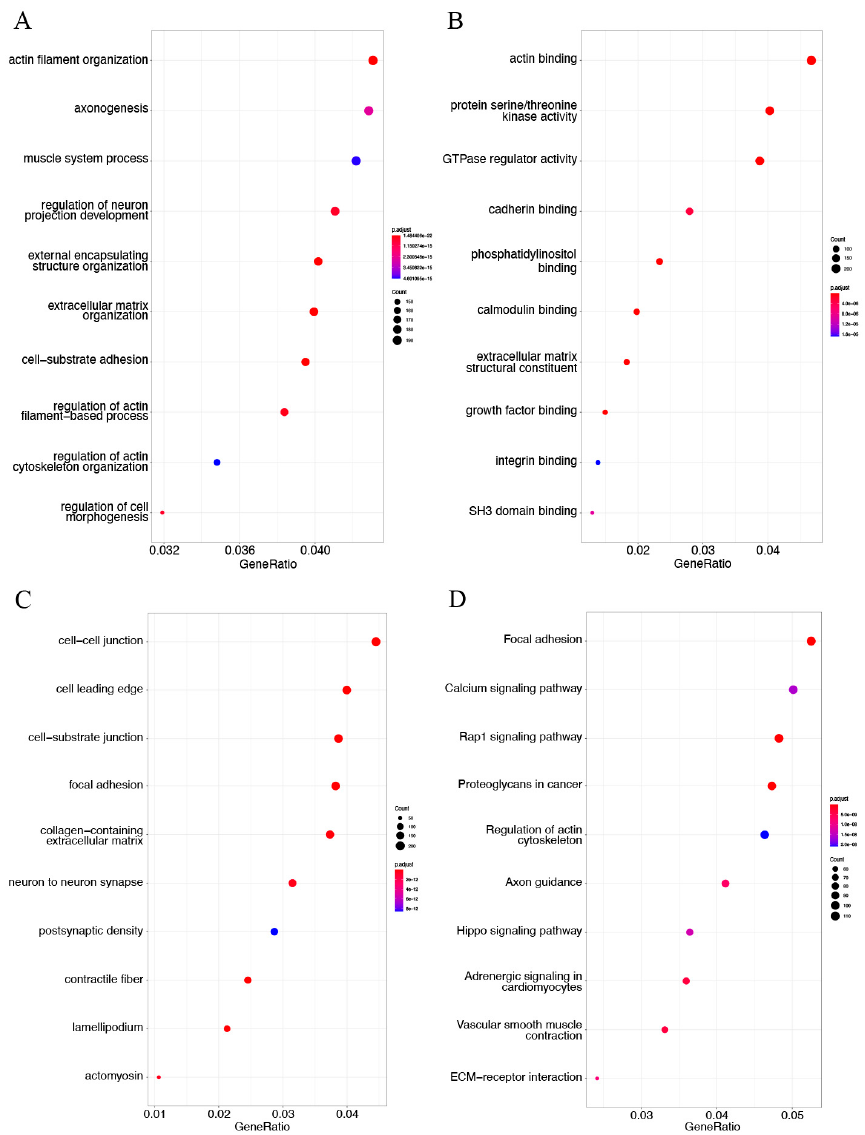
Figure 7. GO term annotation and KEGG pathway analysis of hypermethylated DMGs in AS in GSE46401. Detailed information relating to changes in the ( A ) biological processes (BP), ( B ) molecular functions (MF), and ( C ) cellular components (CC) of hypermethylated DMGs between control samples and atherosclerotic tissues through GO enrichment analysis. ( D ) KEGG pathway analysis of hypermethylated